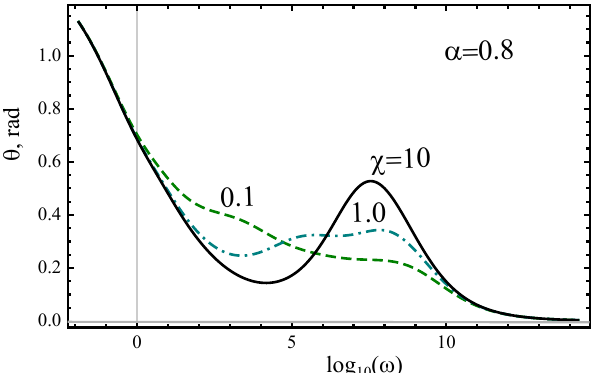
Figure 9. Bode plots for the equivalent circuit with Z RL − CH